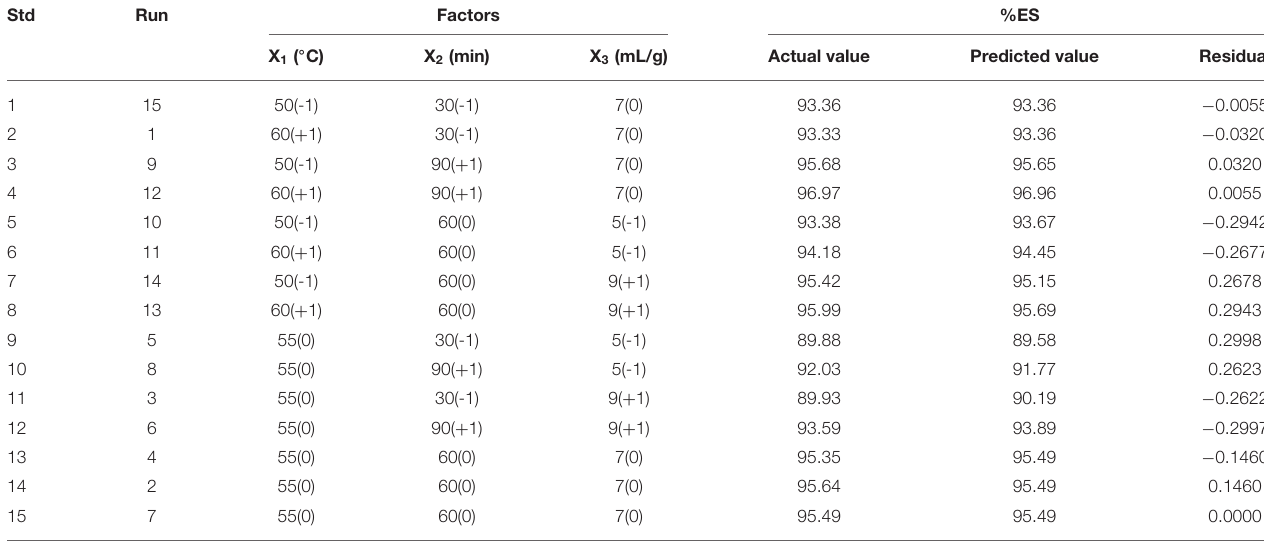
TABLE 1 | Box–Behnken design for the experiments of %ES. Std